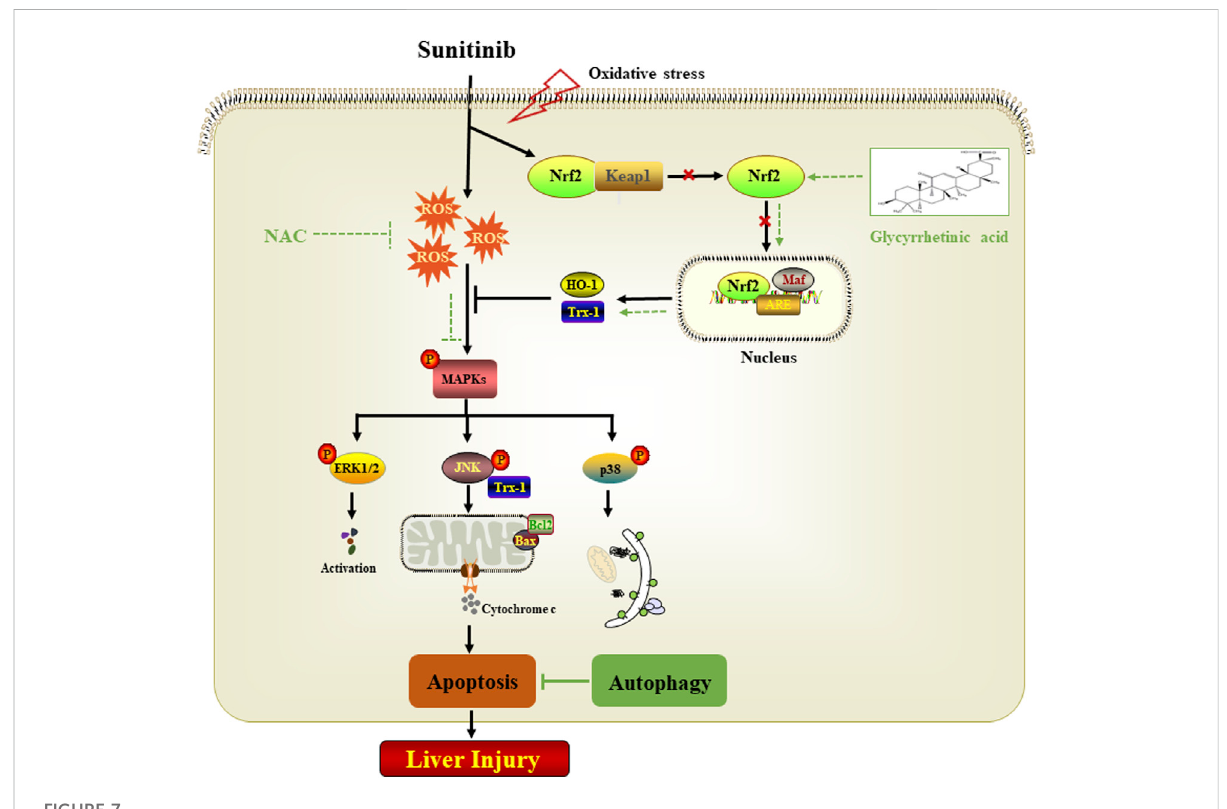
FIGURE 7 Proposed mechanism of Sunitinib-induced